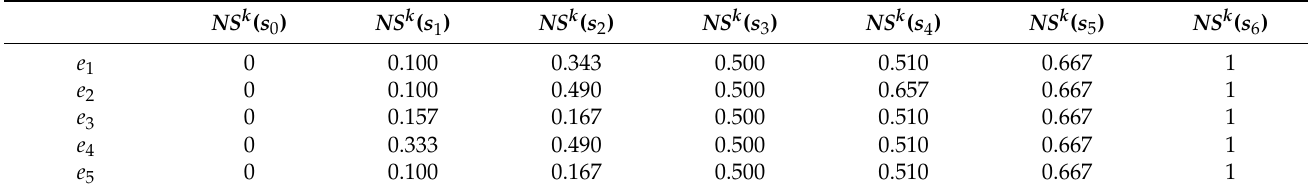
Table 2. Personalized numerical scales of linguistic terms for each expert.